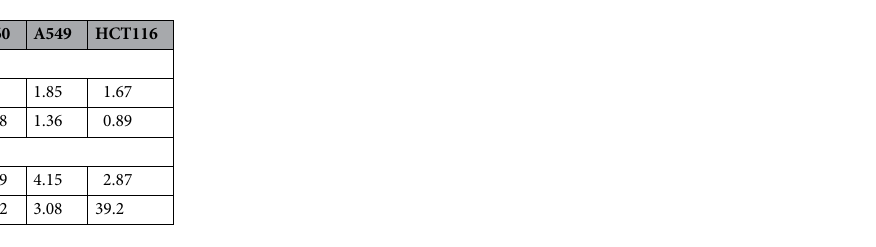
Table 2. The sensitization enhancement ratio after alpha radiation and X-ray